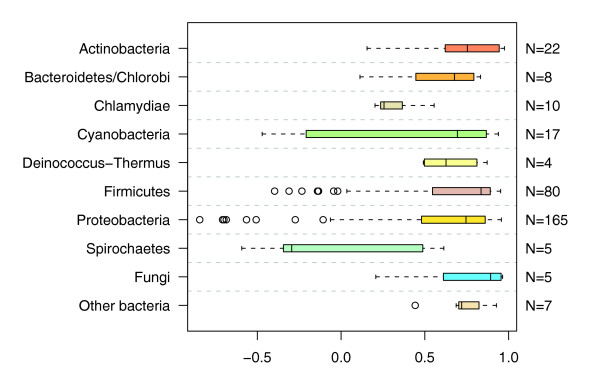
Box plot summarizing correlations between tCAI and dCAI for eight major bacterial phyla and fungi. The group 'Other bacteria' comprises a number of minor bacterial phyla (Aquificae, Chloroflexi, Fusobacteria, Planctomycetes, Acidobacteria, and Thermotogae) that could not meaningfully be included in any of the other categories. The box plot illustrates the median correlations of each group as well as upper and lower quartiles. The numbers on the right side of the figure specifies the number of genomes included in each group. dCAI, dominant codon adaptation index; tCAI, translational codon adaptation index.